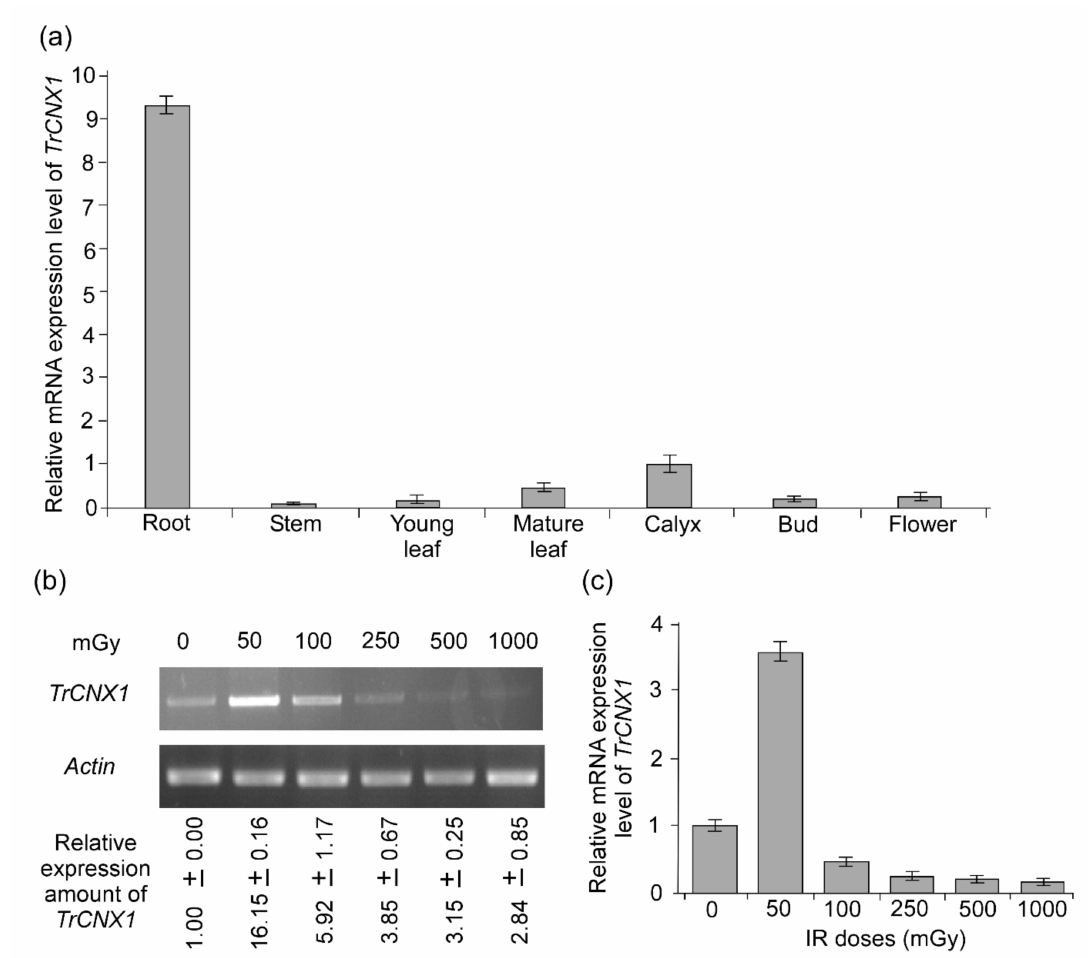
Figure 4. mRNA expression analysis of TrCNX1 genes. The relative expression levels of TrCNX1 genes were normalized to that of the actin reference gene. ( a ) Di ff erential tissue expression of TrCNX1 transcript in Tradescantia . TrCNX1 transcript levels were investigated in seven di ff erent tissues via RT-qPCR. Transcriptional levels of calyx were set as control (the value of 1) to estimate expression in di ff erent organs. ( b ) RT-PCR validation of TrCNX1 gene expression levels in response to various doses of gamma irradiation ( È –IR) treatments (50, 250, and 500 mGy for 1 h, and 1000 mGy for 10 h). Lower panels indicate Tradescantia actin gene amplification. Values with ± standard error represent the relative amounts of calculated TrCNX1 expression as described in the Materials and Methods